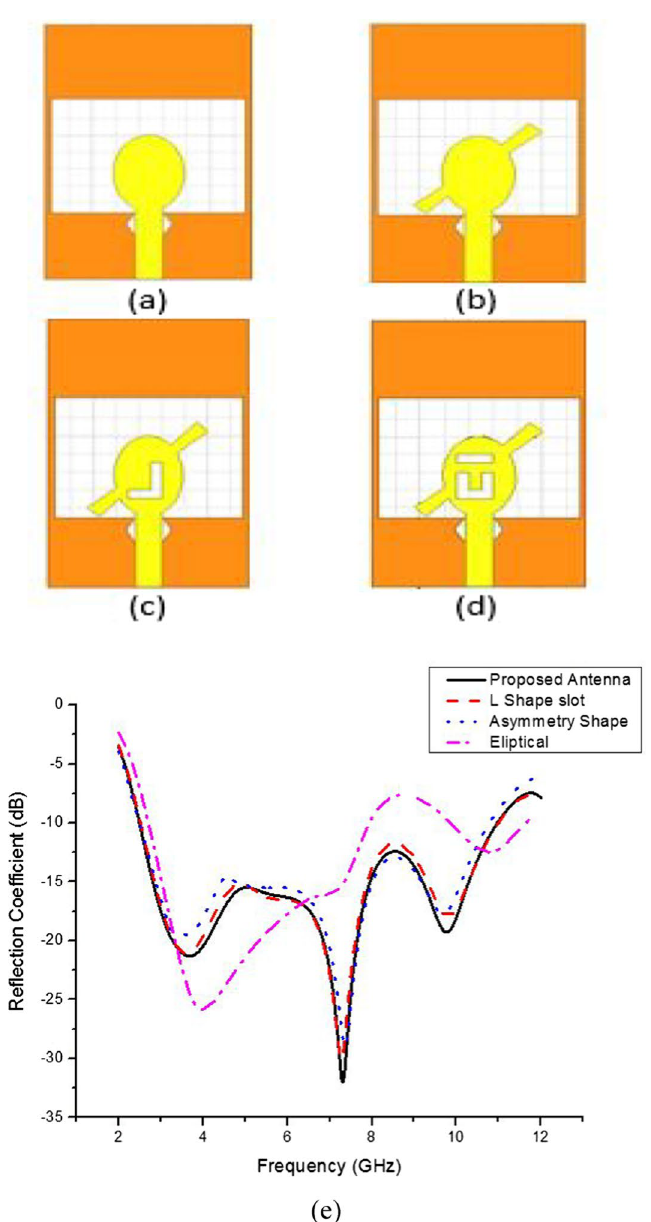
Fig. 1 a – d UWB antennas with same outer dimensions and e Reflection coefficient comparison of ( a – d